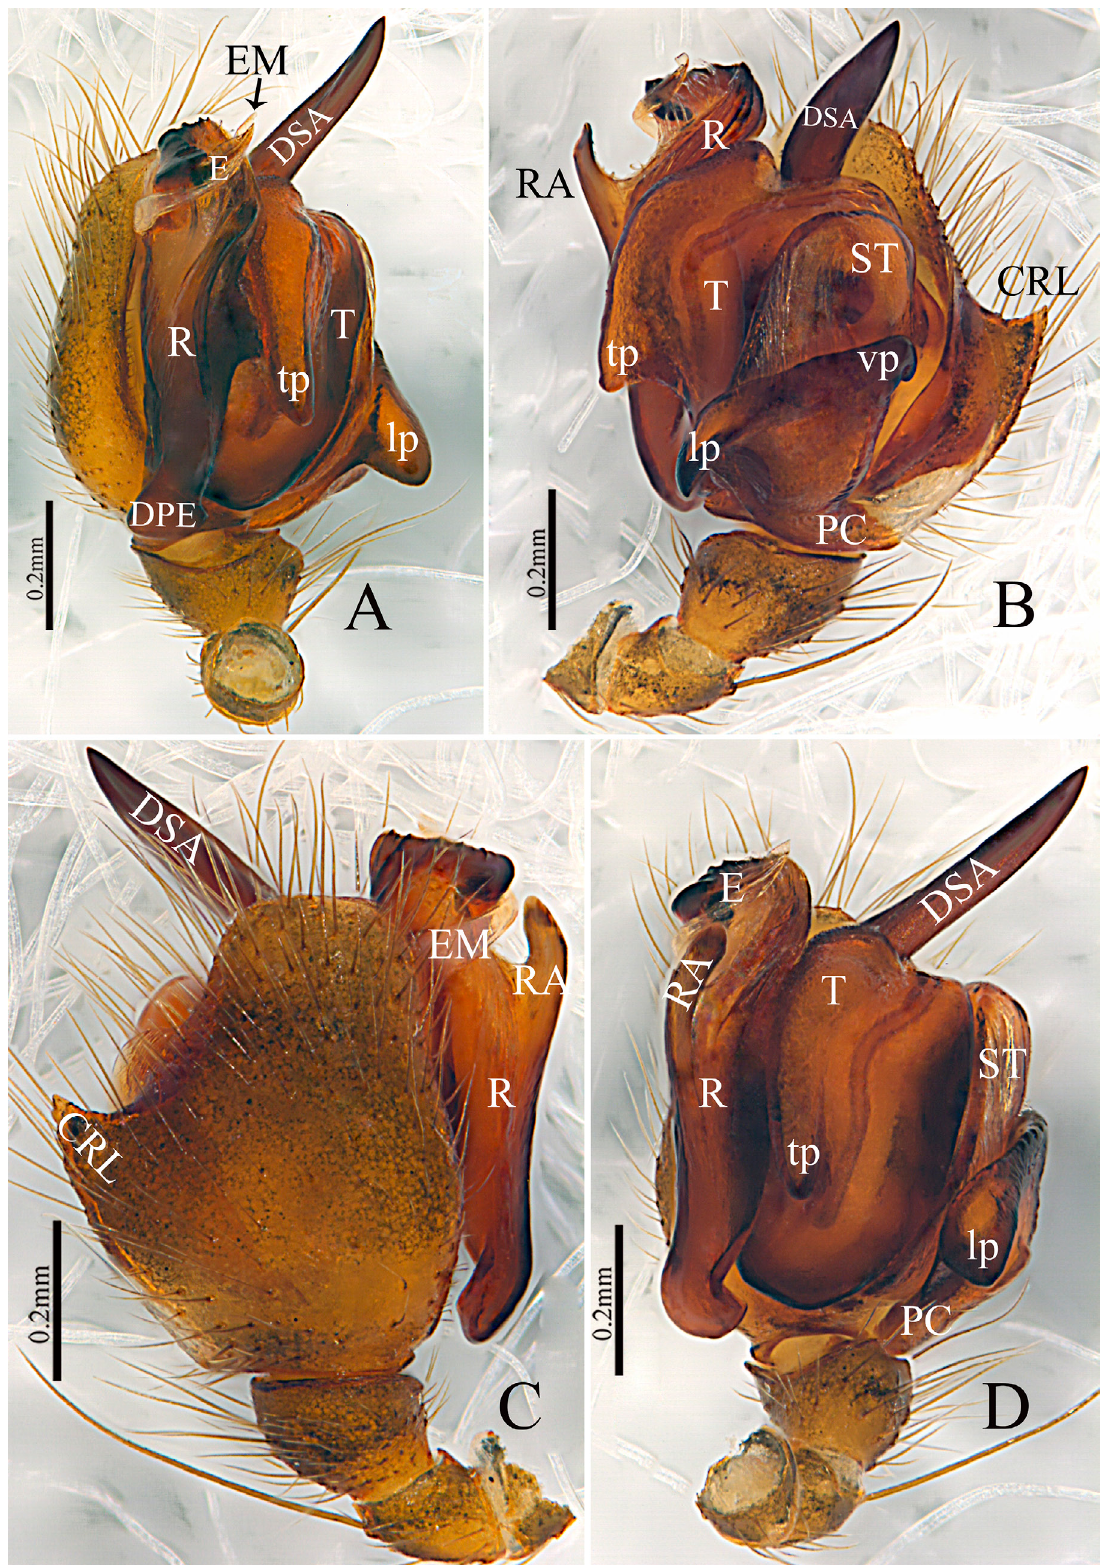
Fig. 30. Acroterius longimultus gen. et sp. nov., ♂, holotype (HNU-20040501–1), palp. A . Prolateral view. B . Retrolateral view. C . Dorsal view. D . Ventral